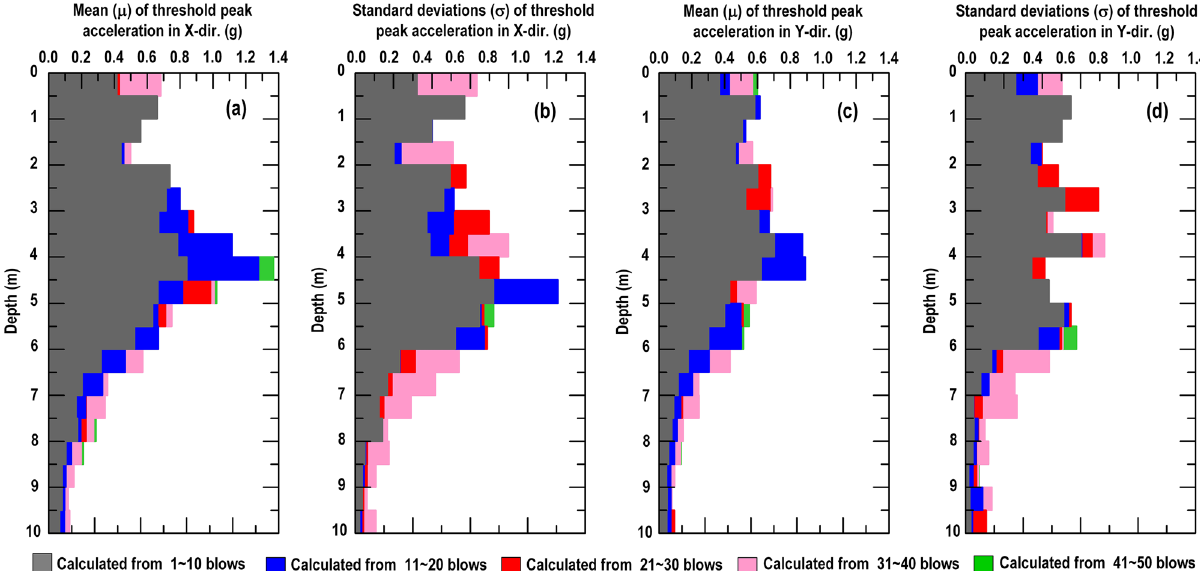
Figure 12. Calculated normal distributions results from the vertically installed SAA string recorded: ( a , c ) mean of threshold peak acceleration in X-direction and Y-direction; ( b , d ) standard deviation of threshold peak acceleration in X-direction and